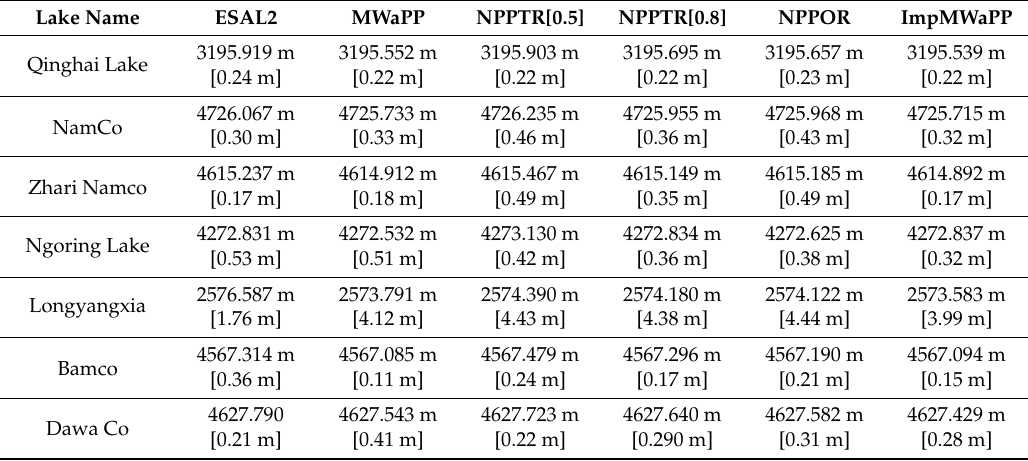
Table A2. Mean and standard deviation of track mean levels used for the Cryosat-2 time series derived by each retracker over each